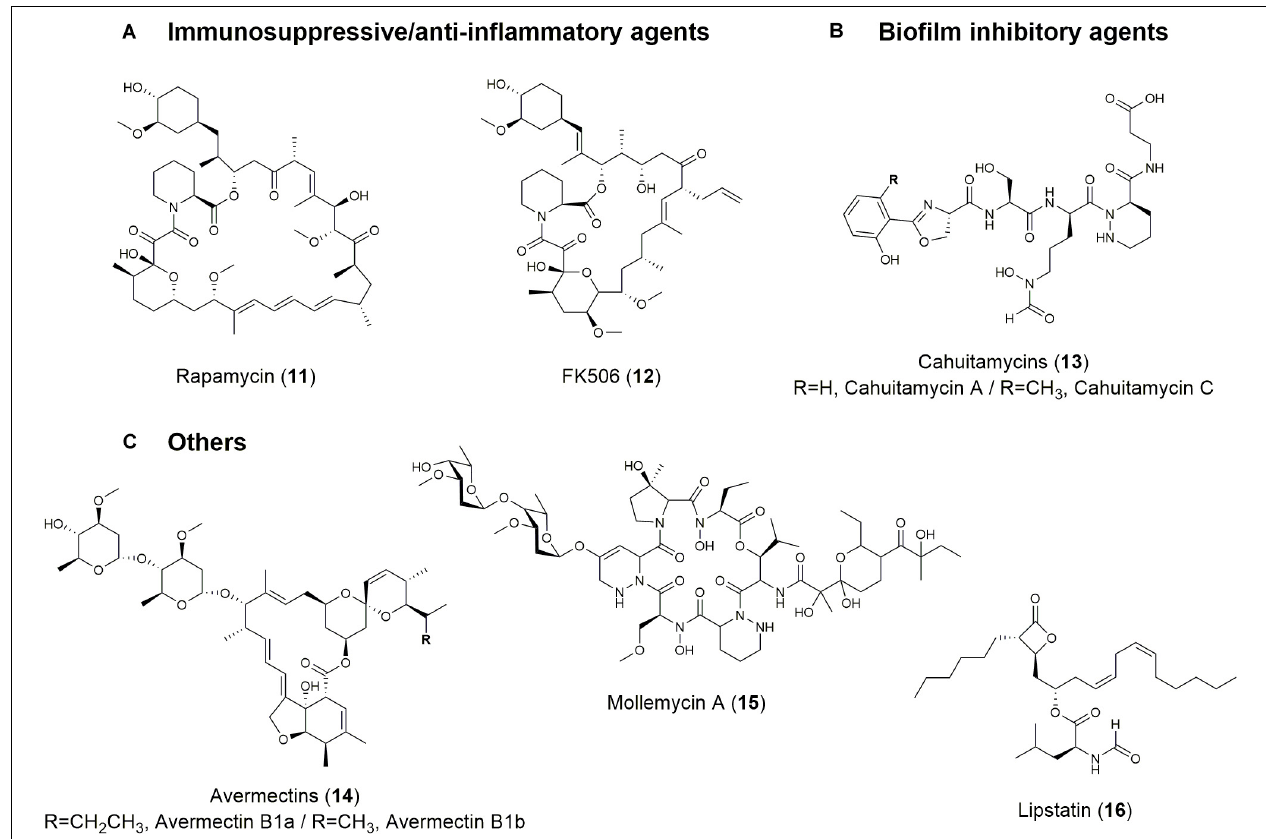
FIGURE 3 | Structures of natural products with (A) immunosuppressive/anti-inflammatory, (B) biofilm-inhibitory, and (C) other activities.